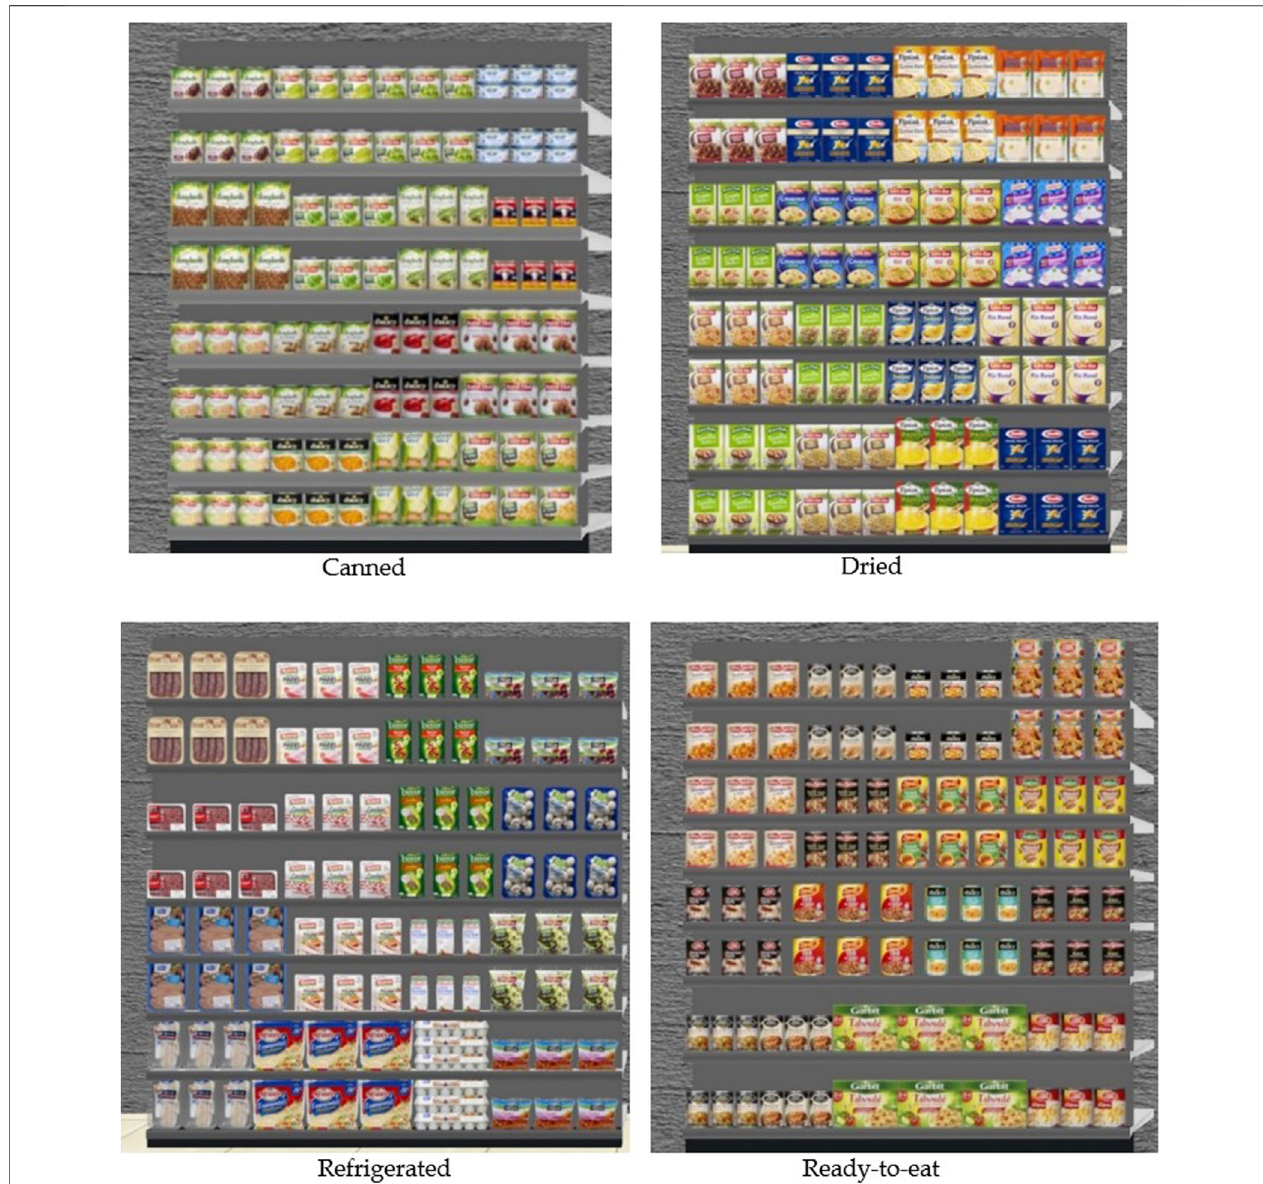
FIGURE 1 | An example of the visual design of the four shelves built for the experiment.